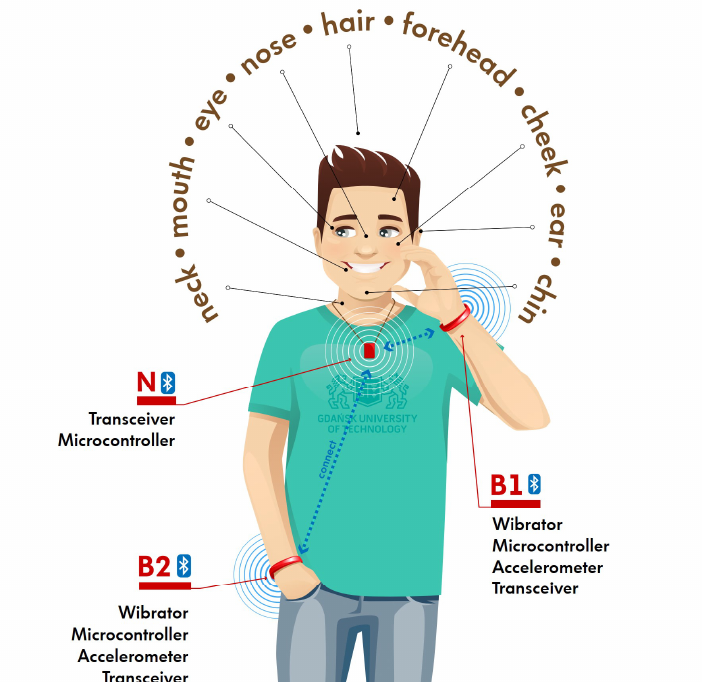
Figure 1. The scheme of the proposed WBAN system with a star topology. It consists of two BLE wireless modules placed on the wrists (B1 and B2) and one module placed on the neck